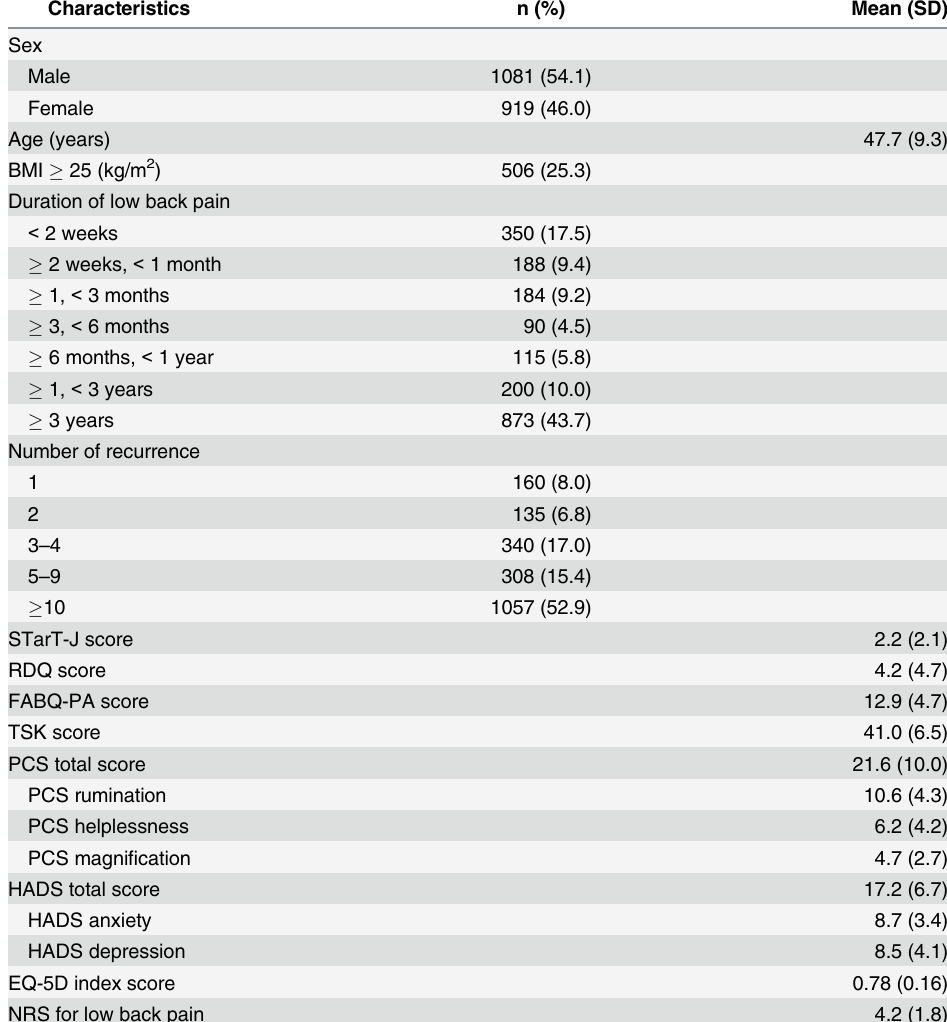
Table 1. Participant characteristics: psychometric testing of the STarT-J (n = 2000).